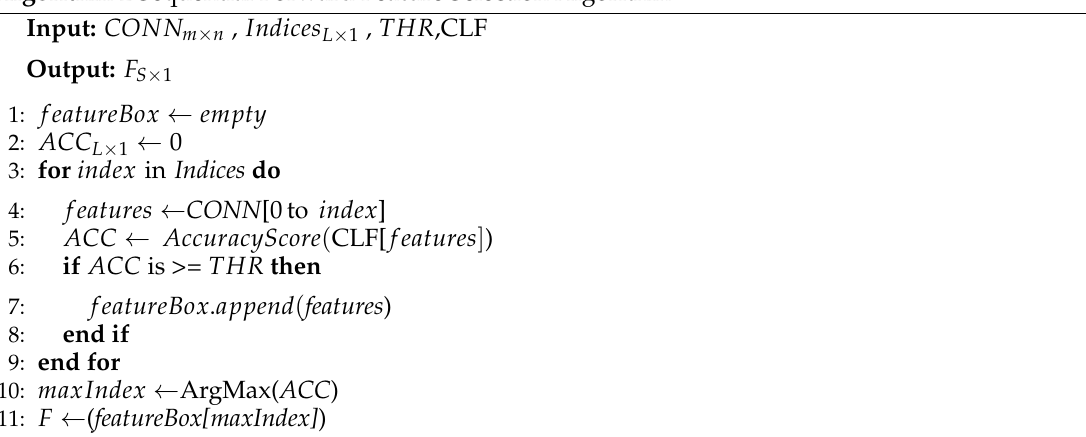
Algorithm 2 Sequential Forward Feature Selection